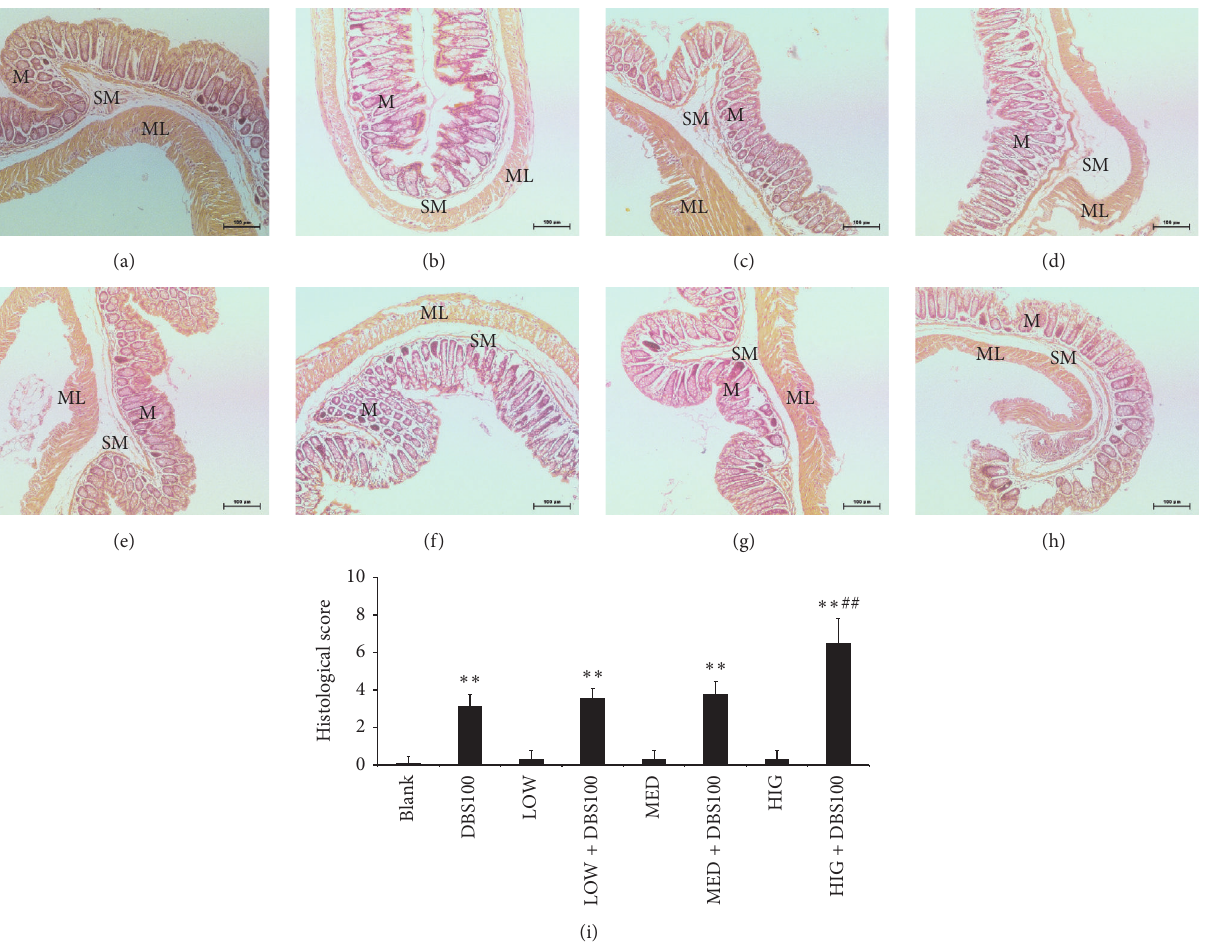
Figure 7: The impact of 𝜅 -carrageenan on histological changes and the HAI scores of Citrobacter freundii DBS100-stimulated mice. (a) Blank group; (b) DBS100 treated alone; (c) LOW treated alone; (d) LOW + DBS100 cooperative accessing; (e) MED treated alone; (f) MED + DBS100 cooperative accessing; (g) HIG treated alone; (h) HIG + DBS100 cooperative accessing. H&E: × 200. (i) The HAI scores of colonic in C. freundii DBS100-stimulated mice. ∗∗ 𝑃 < 0.01 , compared with the blank group; ## 𝑃 < 0.01 , compared with the DBS100-treated group. M, mucosa; SM, submucosa; ML, muscle